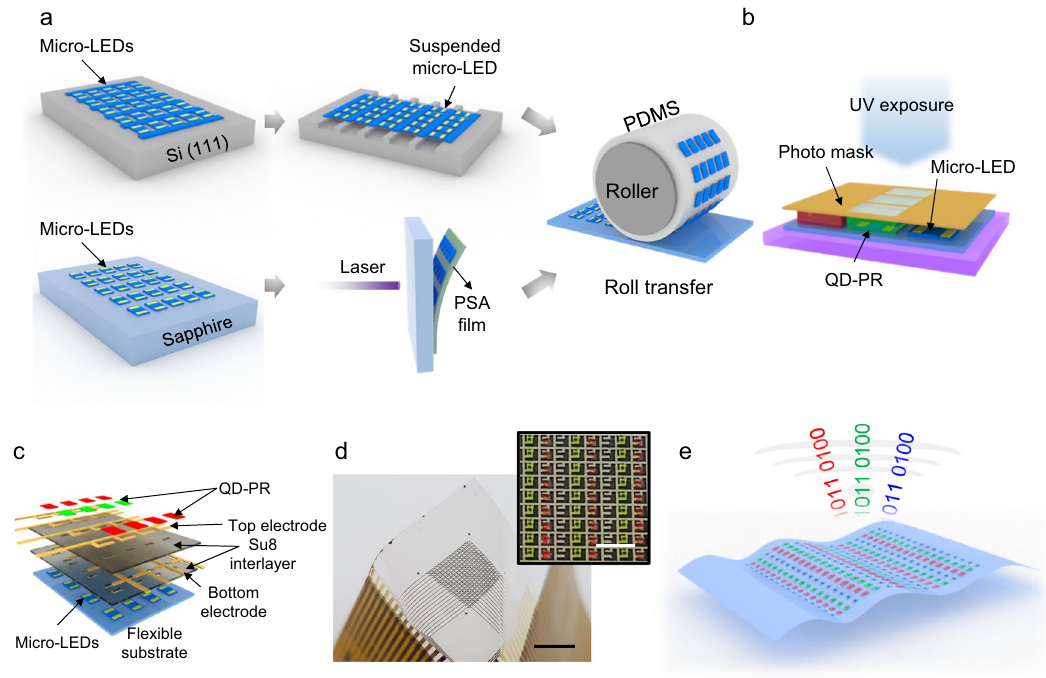
Fig. 1 QD-based fl exible micro-LED display for VLC application. a Schematic of transferring a micro-LED array from mother substrate to target substrate using roll transfer. b Patterning of QD-PR on micro-LED array using conventional photolithography. c Schematic illustration of the interconnection of micro-LED display in passive matrix con fi guration. d Optical image of micro-LED display fabricated on plastics substrate and magni fi ed image (inset) of patterned QD-PR on micro-LED display. Scale bar: 5 mm. Scale bar: 1 mm (inset). e Schematic shows a fl exible micro-LED display and 3-channel wireless communication through the visible light